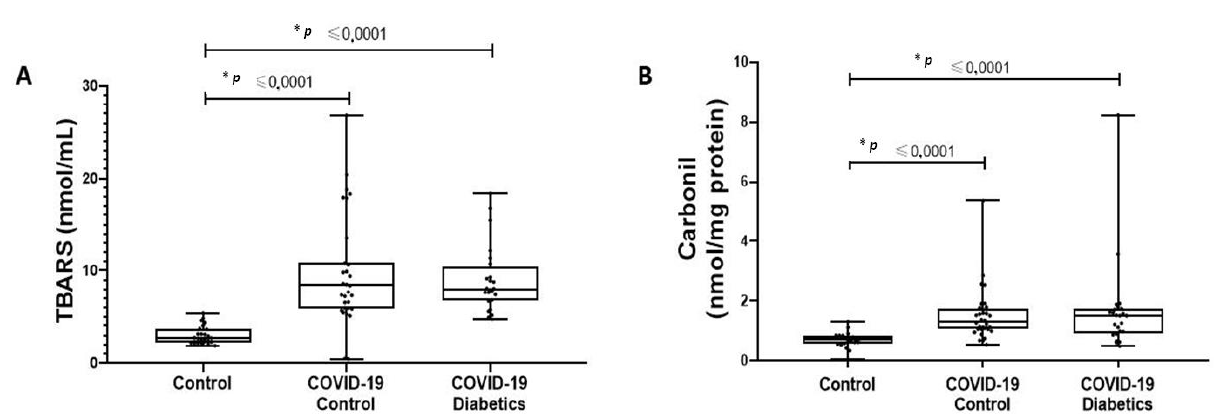
Figure 5. Comparison of lipid ( A ) and protein ( B ) oxidative damage between critically ill patients with COVID-19 pneumonia with and without diabetes, noninfected healthy subjects. * When different from noninfected healthy subjects. p < 0.05. Data expressed as mean ±